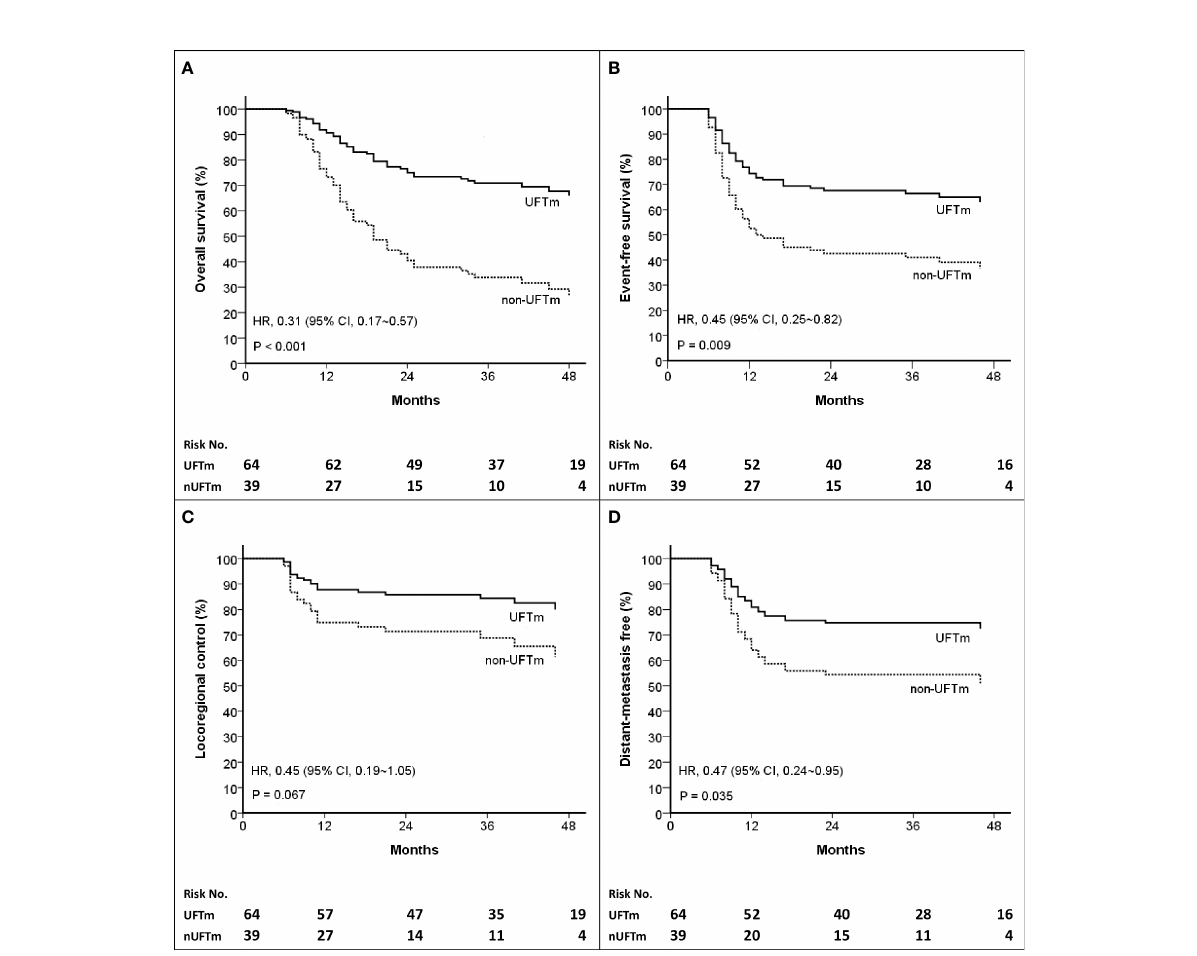
FIGURE 2 Kaplan – Meier curves of (A) Overall survival (B) Event-free survival (C) Locoregional control, and (D) Distant-metastasis free. HR , hazard ratio; CI , con fi dence interval; UFT , tegafur-uracil; UFTm , UFT maintenance; nUFTm, non-UFTm